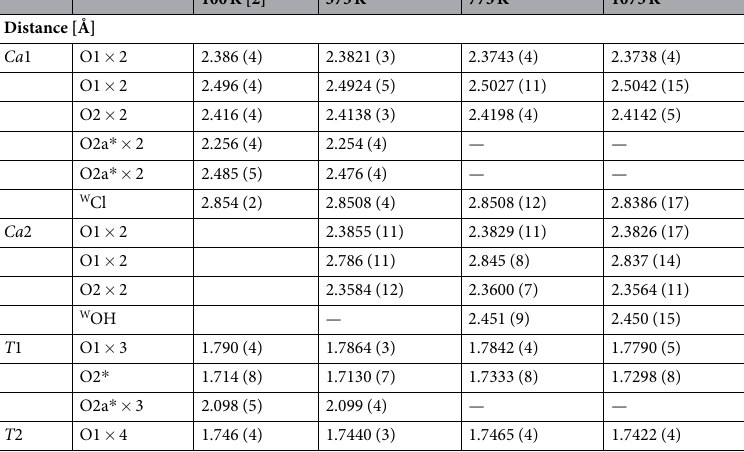
Table 1. Selected interatomic distances of untreated chlormayenite 2 and annealed crystals at 573 K and 773 K and 1073 K. * Either O 2 or 3 × O 2a are occupied.